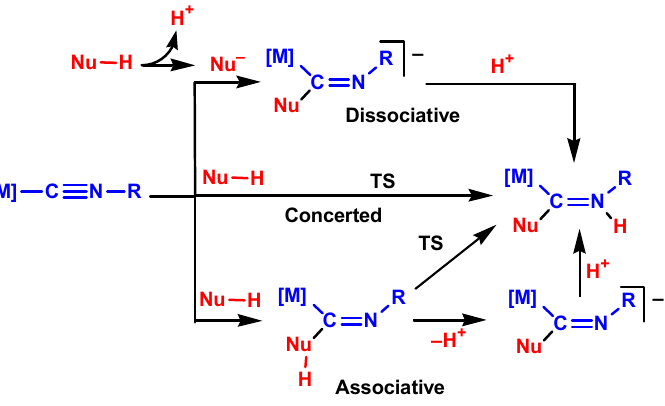
Scheme 2. Mechanisms of nucleophilic addition to metal-bound isocyanides (only one isomeric pathway is shown, formal charges are omitted).